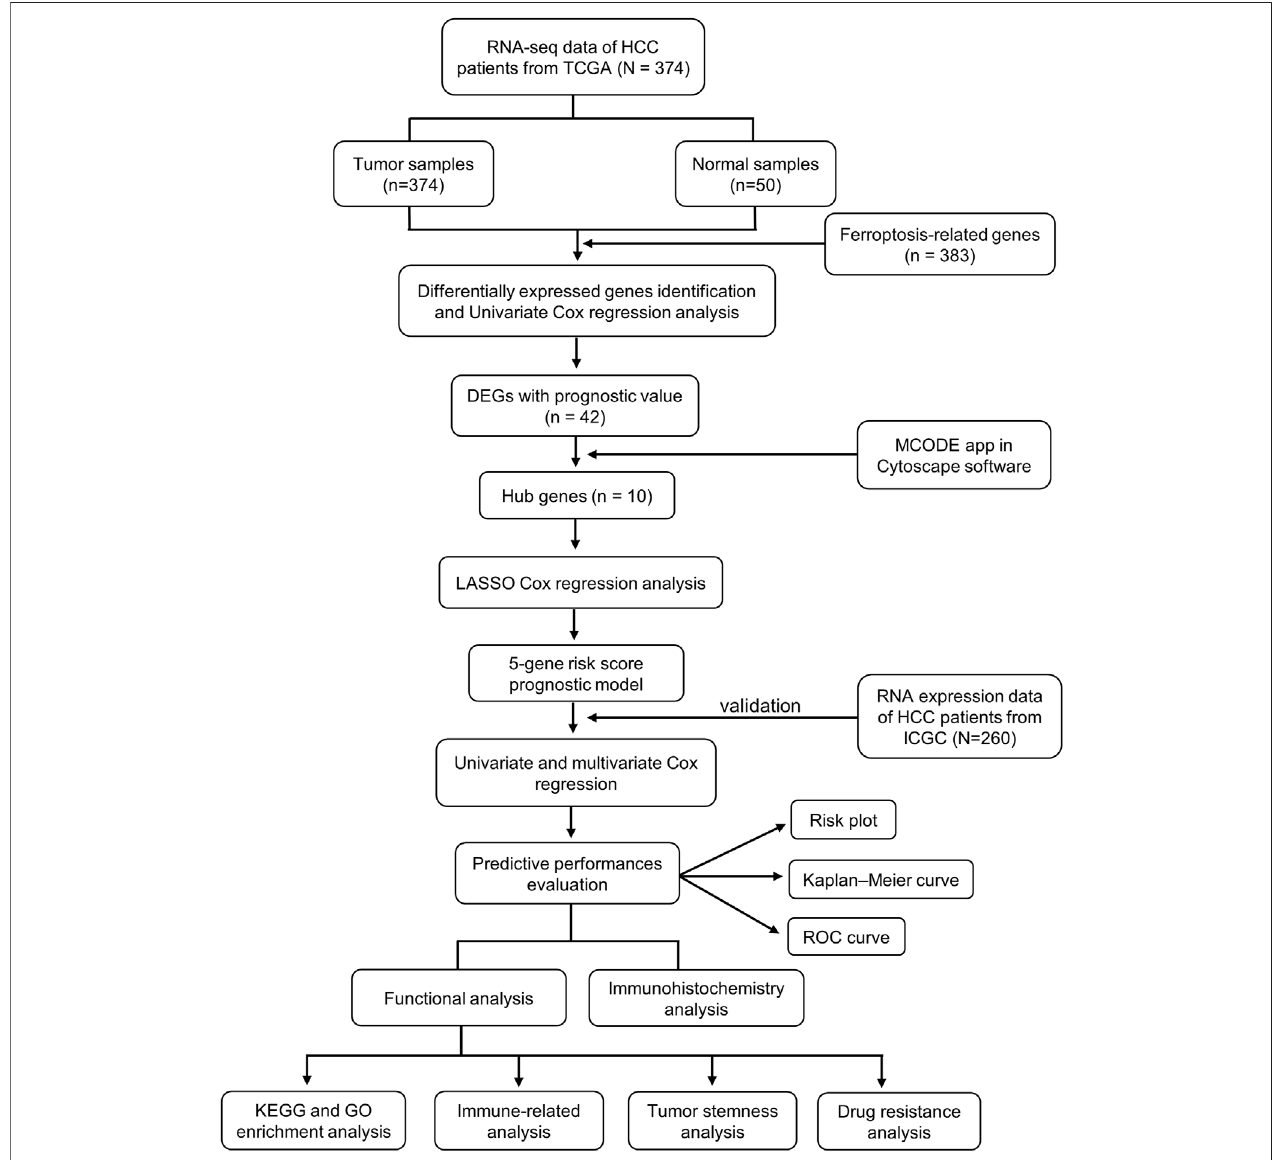
FIGURE 2 | The fl ow diagram of data collection and analysis in the present